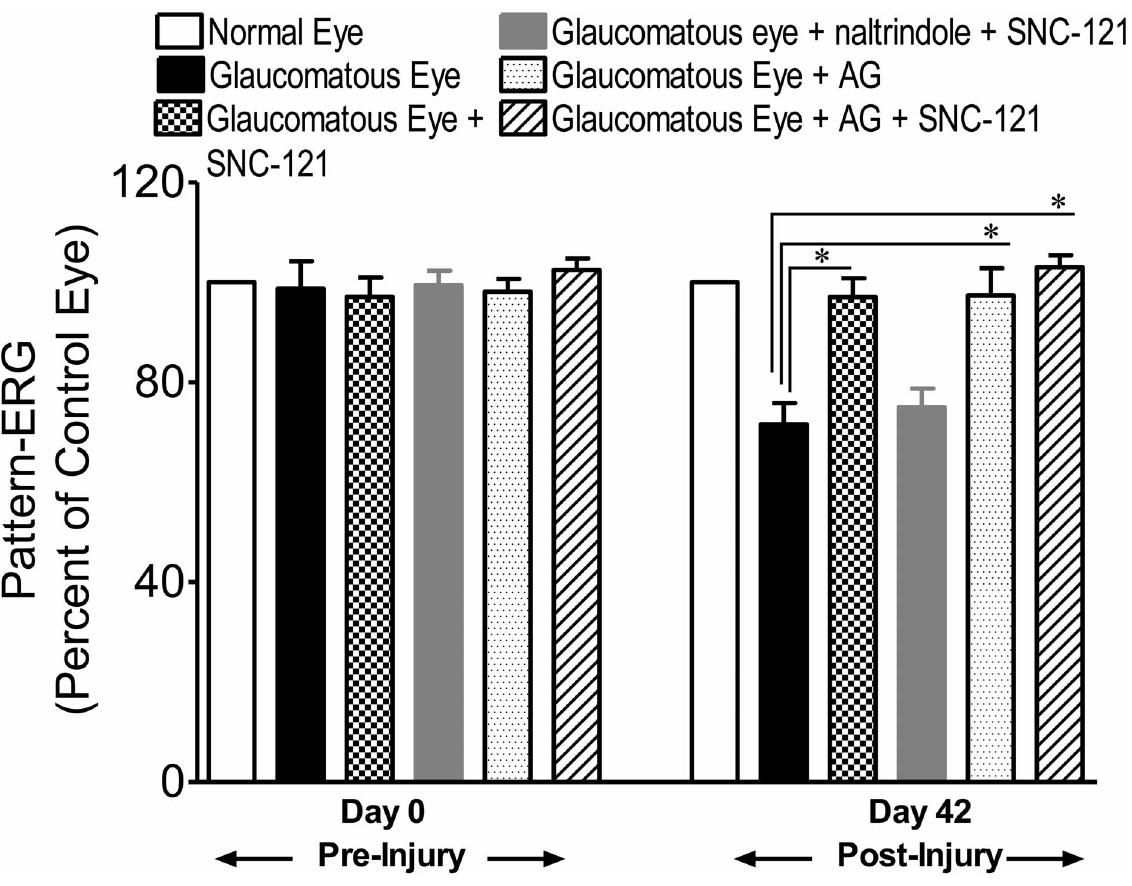
Figure 2. Pattern ERG recordings in normal and glaucomatous eyes. Changes observed in Pattern ERGs of untreated, AG or SNC-121-treated glaucomatous rat eyes are shown as a percentage of the contralateral control eye. In these experiments, Brown Norway rats were treated with AG (25 mg/kg, i.p.) or SNC-121 (1 mg/kg, i.p.), individually or together simultaneously, 30 minutes after hypertonic saline injections. Animals were treated with naltrindole 30 minutes after glaucomatous injury followed by SNC-121 treatment. The drug treatment was continued once daily for 7 days in all groups. Data are mean 6 SE; * P , 0.05; n=7–8.